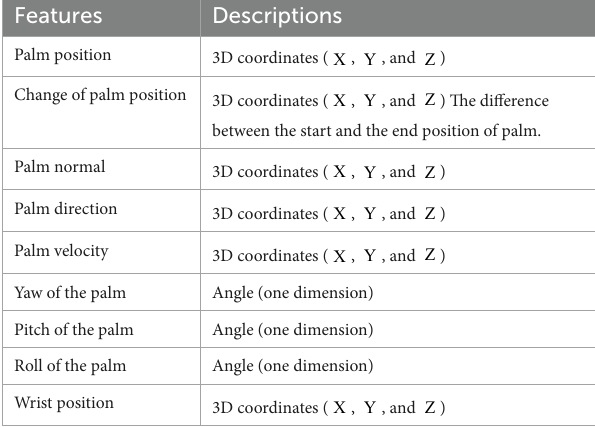
TABLE 1 Descriptions of CSL collected from leap motion